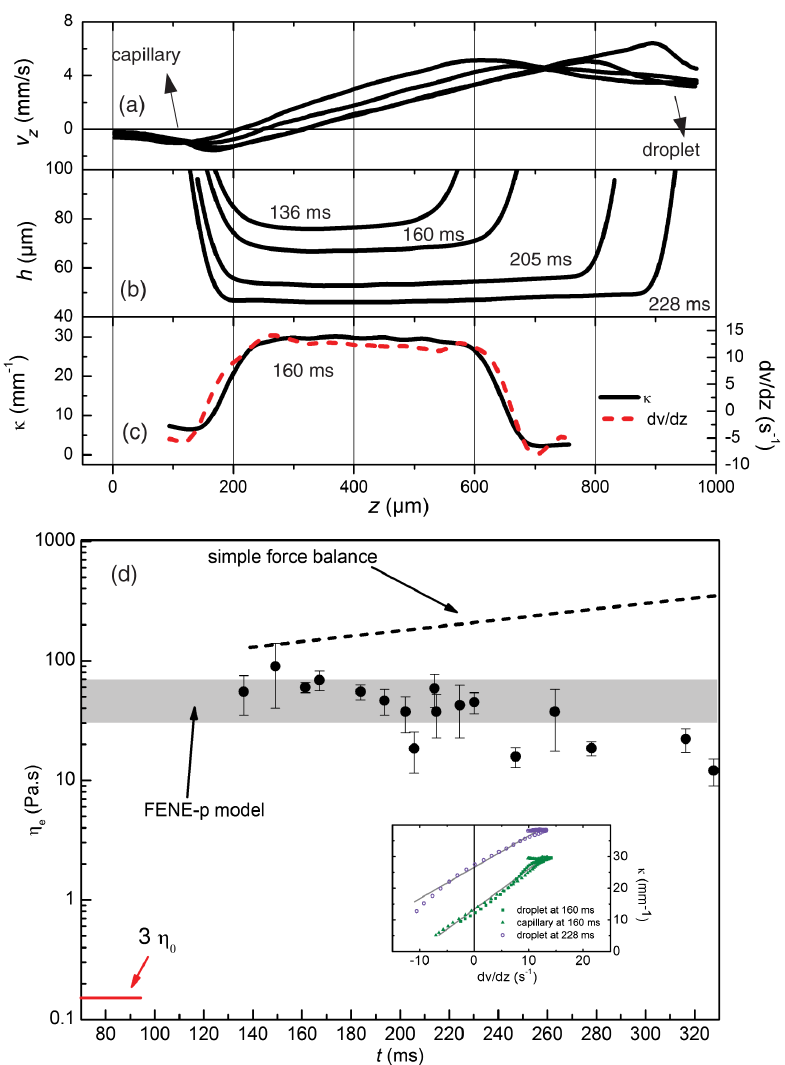
FIG. 3. Extensional viscosity: (a) Axial velocity profiles and (b) filament diameter at four different times during the exponential (dashed line). (d) (cid:3) e (dots) extracted from (cid:6) versus _ " . Dashed line: (cid:3) e using the force balance regime. (c) (cid:6) (solid line) and _ " ¼ @v @z within the filament only. Note the low value of the extensional viscosity at early times deduced from the low shear viscosity of the solution and from the similarity in the early-time dynamics between the polymer solution and the reference Newtonian fluid. Gray region: Model values, taking into account the uncertainty on the value of the solution relaxation time. Inset: (cid:6) versus _ " for two different times during the exponential